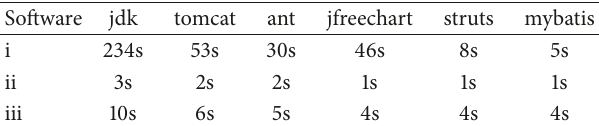
Table 8: CPU time required for each step ( 𝑇 = 10, 000 and 𝑈 = 1 in Algorithm